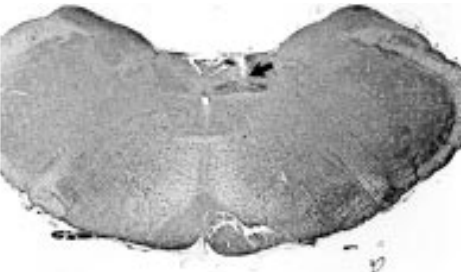
Figure 5 - Photomicrograph of a coronal section of the brain stem of one rat representative of the groups studied showing a typi- cal unilateral microinjection site centered in the lateral portion of the commissural NTS at the level of the rostral edge of the area postrema, approximately 0.5 mm rostral to the calamus scrip- torius and 0.5 mm lateral to the midline